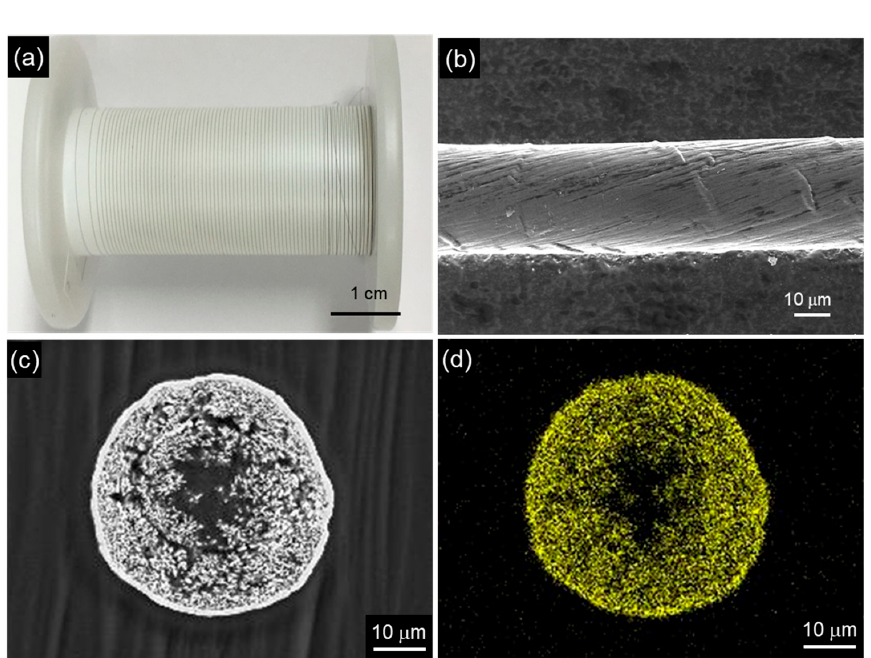
Figure 16. CNT/Cu composite yarn by electrodeposition using a CNT yarn as the template. ( a ) Appearance of CNT yarn, ( b ) SEM image of the CNT yarn, ( c ) Cross-sectional SEM image of CNT/Cu composite yarn by electrodeposition using a plating bath with additives, ( d ) Cu distribution of ( c ). (Figure 16 is adapted from